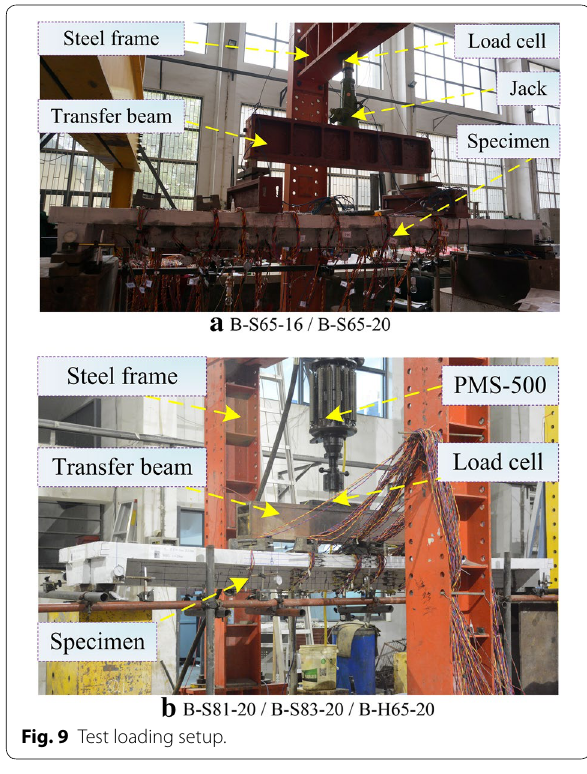
Fig. 9 Test loading setup.